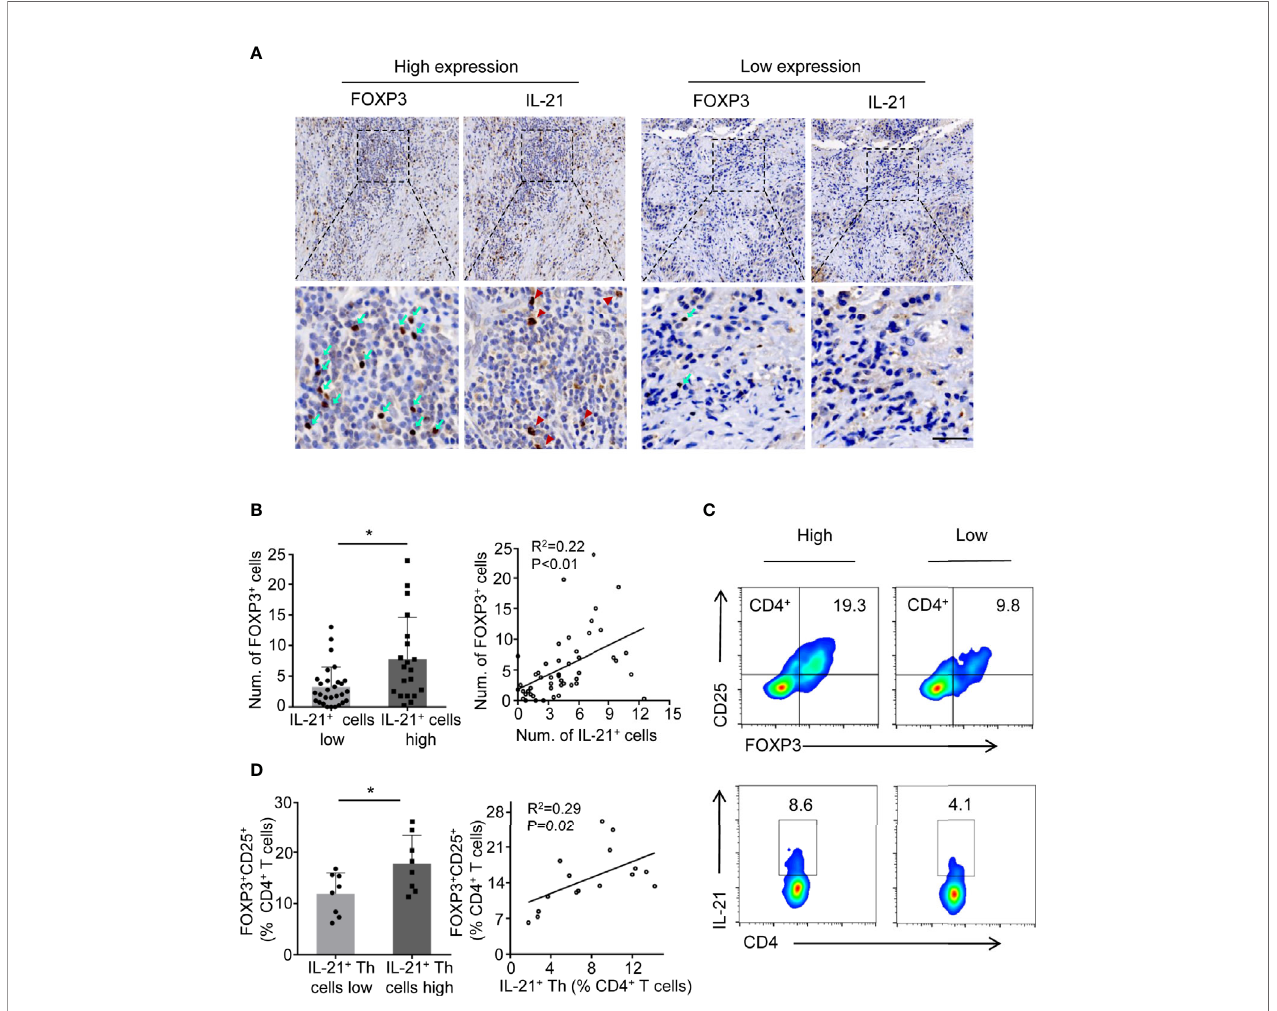
FIGURE 3 | IL-21 + Th cells accumulation is positively correlated with Treg in fi ltration in HNSCC tissues. (A) High and low expression of FOXP3 (cyan arrows) and IL- 21 (red arrowheads) positive cells at the same area of stroma. Scale bar, 50 m m, magni fi cation, bottom panels 400×, upper panel 100×. (B) Correlation between FOXP3 + and IL-21 + cells using immunohistochemical analysis. n=49. (C) Representative fl ow cytometric plots of tumor in fi ltrating FOXP3 + CD25 + CD4 + and IL- 21 + CD4 + T cells. (D) Correlation between FOXP3 + and IL-21 + cells using fl ow cytometric analysis. n=16. In immunohistochemical analysis, the median level of IL-21 + cells was 4.5 cells per fi led. In fl ow cytometric analysis, the median percent of IL-21 + Th in CD4 + T cells was 7.75%. (*P < 0.05 by Student ’ s